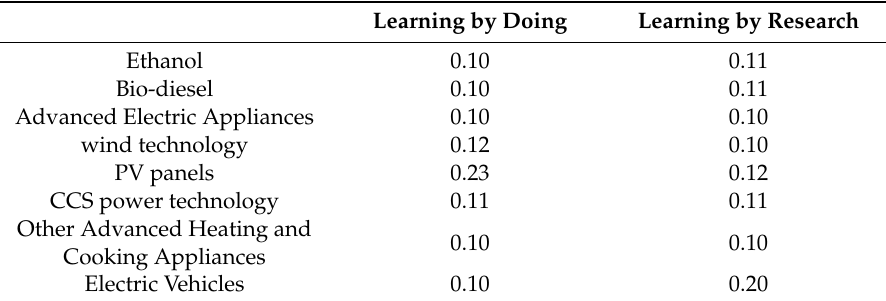
Table 1. Learning rates used in